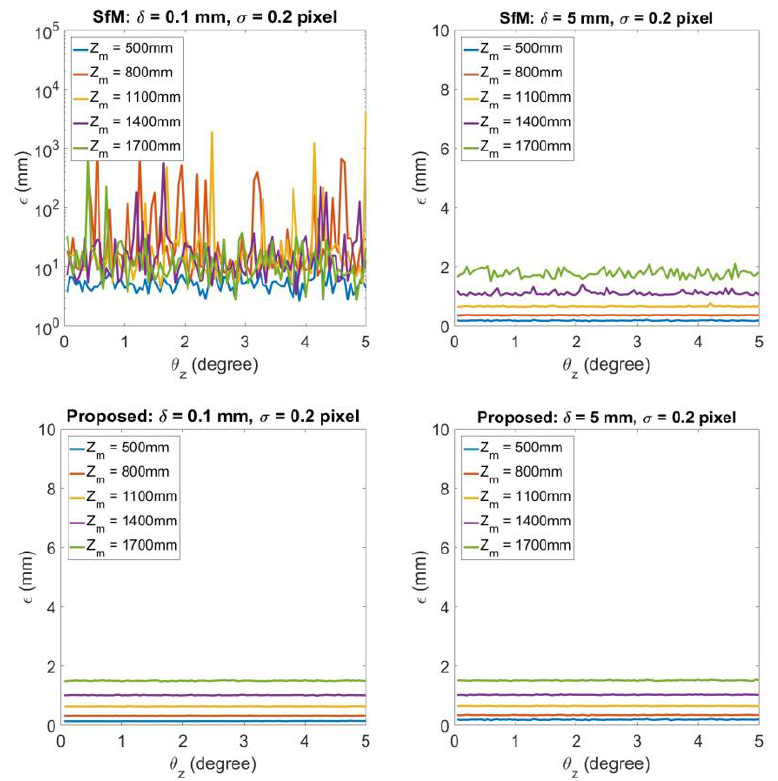
Figure 10. 3D reconstruction error for θ z = 0.05 ◦ ,0.1 ◦ , . . . ,5 ◦ . From left to right each column